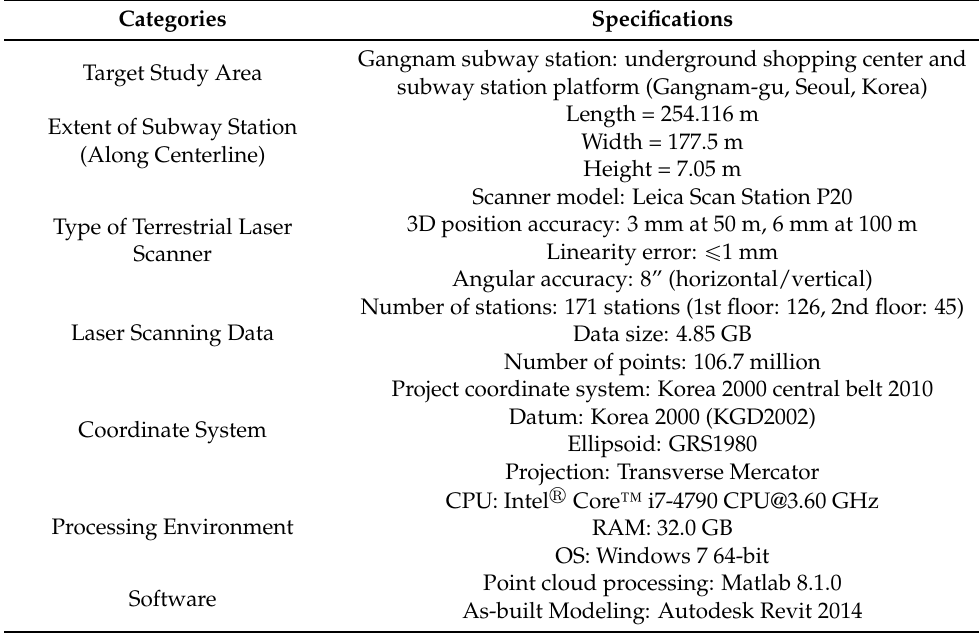
Table 1. Point cloud acquisition and test environment